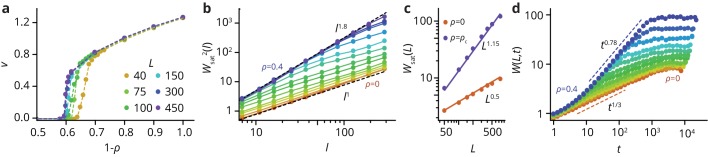
Characterization of Eden clusters with obstacles (k=0).(a) Taking the front speed v as the order parameter, there is a phase transition at a critical obstacle density ρc⁢(L) depending on system size L. For an infinite system, ρc≈0.41±0.01. For ρ<ρc, we have v∼|ρ-ρc|0.21. (b) Roughness W of fully developed interfaces at L=400 for varying obstacle densities, as a function of the window length l, such that W∼tα. At ρ=0, we find α=1/2, consistent with the KPZ universality class. At ρc, we find αloc≈0.9, consistent with the QEW universality class (see Theory in the Materials and methods section), which is known to be characterized by two roughness exponents, a local exponent (αloc, panel b), and a global exponent αG≈1.15>αloc when the roughness is measured over the whole system size (see panel c) (Amaral et al., 1995). Importantly for 0<ρ<ρc, there is a crossover length scale below which the system displays QEW scaling, whereas it returns to the KPZ scaling on longer length scales. (d) The time evolution W⁢(t)∼tβ of the interface also follows dynamics consistent with KPZ (β=1/3) and QEW (β≈0.78) in the limiting cases. For intermediate 0≪ρ≪ρc, there is a crossover from qEW at short times to KPZ dynamics at longer times, before the roughness saturates at a ρ-dependent value. For easier analysis, all simulations were performed in a box-like geometry.10.7554/eLife.44359.026Figure 4—figure supplement 1—source data 1.Source data for Figure 4—figure supplement 1 (Analysis of colony expansion rate (v(rho).xlsx), interface width as a function of window length (w(l).xslx) and time (w(t).xslx), and saturation width (Wsat.xlsx)).